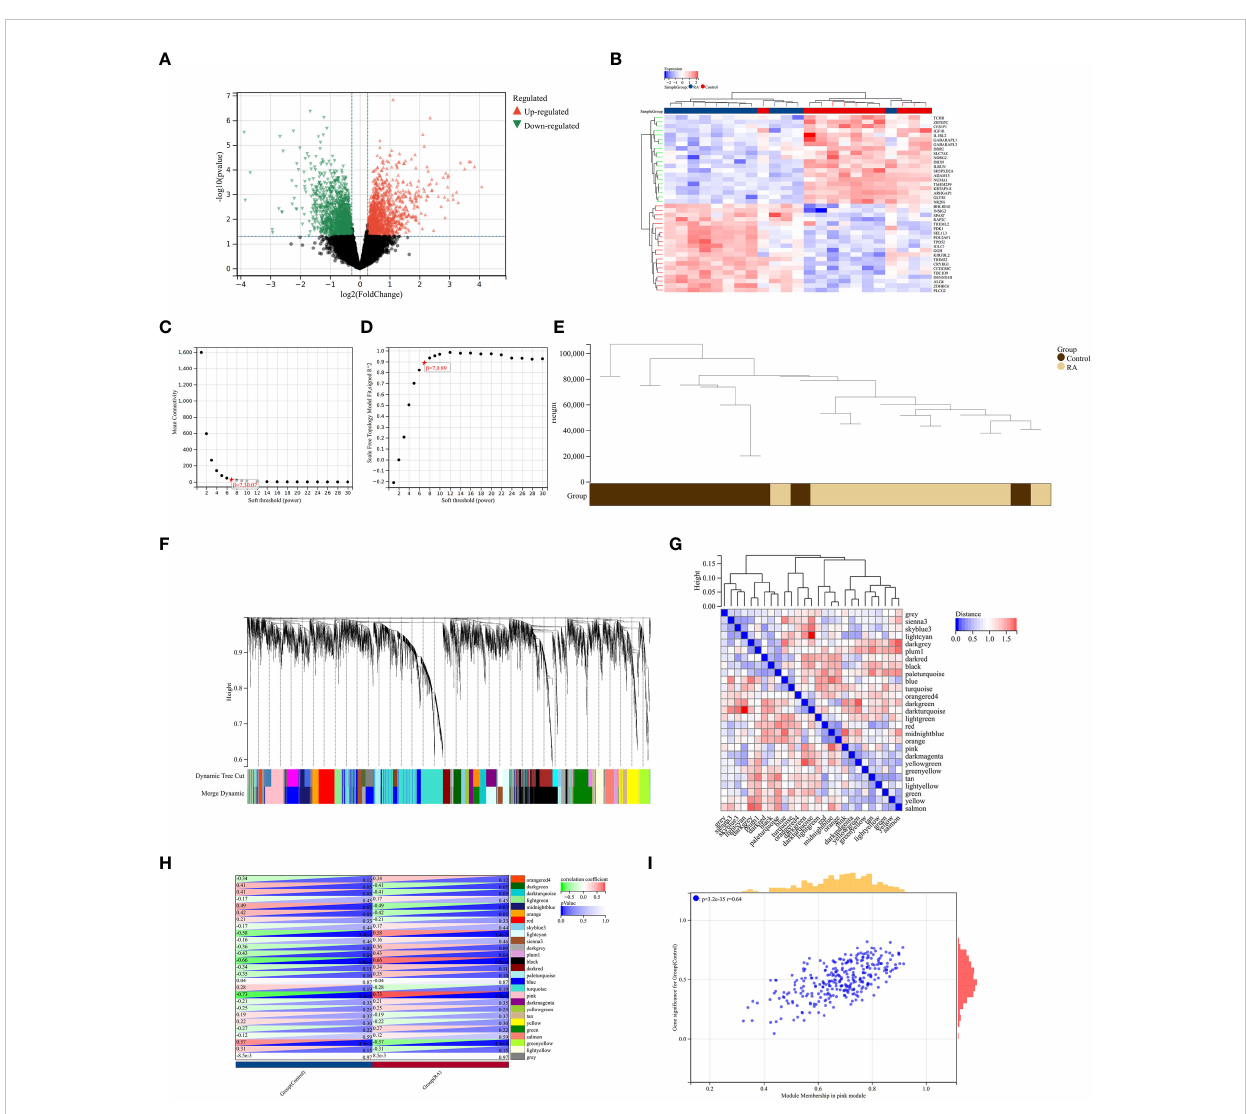
FIGURE 3 Identi fi cation of DEGs via Limma and WGCNA module genes in RA. (A) The volcano plot represents DEGs, of which the red and green triangles refer to signi fi cant genes. (B) The heatmap shows the top 20 upregulated and downregulated DEGs from the RA dataset, which are shown in red and blue colors. (C, D) b = 7 is chosen as the soft threshold based on the scale independence and average connectivity. (E) Clustering dendrogram of the RA and control samples. (F) Gene co-expression modules with different colors under the gene tree. (G) Heatmap of eigengene adjacency. (H) Heatmap of correlation between module genes and RA shows that the pink module has the highest association with RA. For each pair, the top left triangle is colored to represent the correlation coef fi cient; the bottom right one is colored to indicate the p -value. (I) Correlation plot between module membership and gene signi fi cance of magenta module